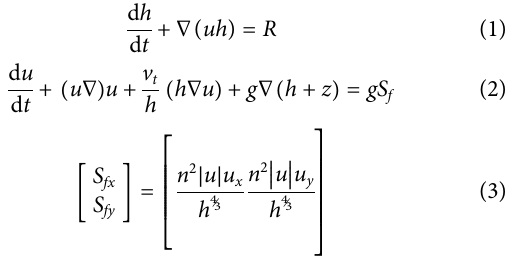
Frontiers in Earth Science |